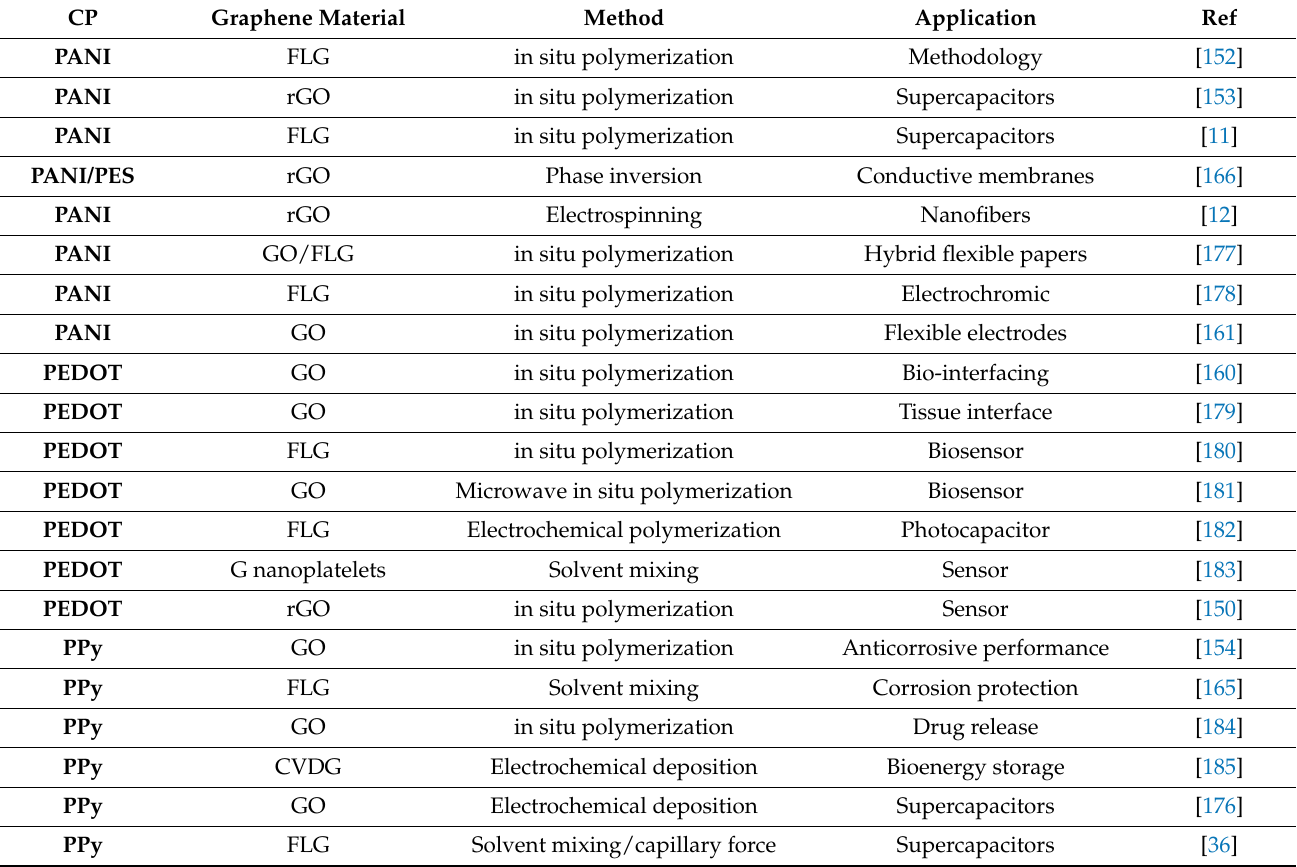
Table 1. Summary of graphene-based materials embedded in conductive